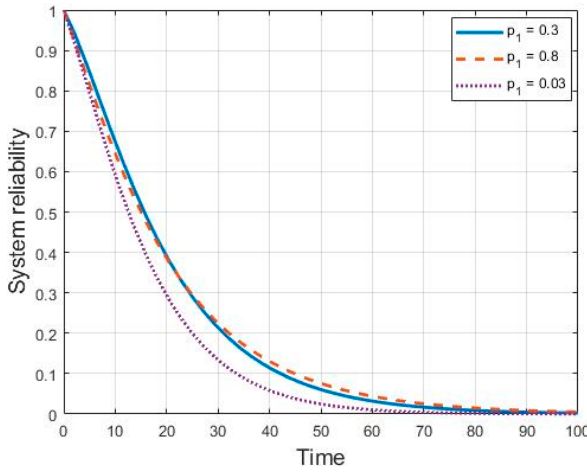
Figure 11. System reliability comparison with the changes of probability ( p 1 ) of detecting partial failures.